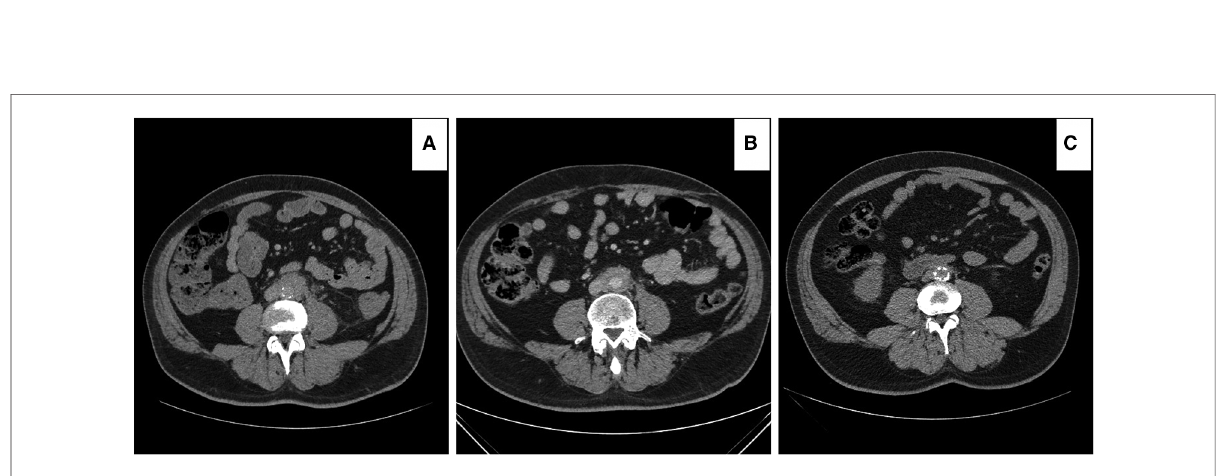
FIGURE 8 Computed tomography angiography (CTA) images showing improvement of the peri-aortic soft tissue enhancements following endovascular aneurysm repair (EVAR). ( A ) Initial peri-aortic soft tissue enhancement of 6 mm. ( B ) failure of medical treatment at 15 months with an enhancement increment to 8 mm. ( C ) Nine months post-EVAR, enhancements of 2 mm. All the symptoms and signs disappeared, and the patient is living a symptom-free